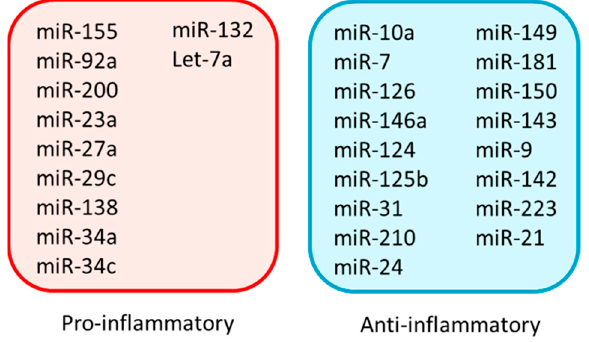
Figure 3. A list of pro- and anti-inflammatory miRNAs in the context of various disease conditions.